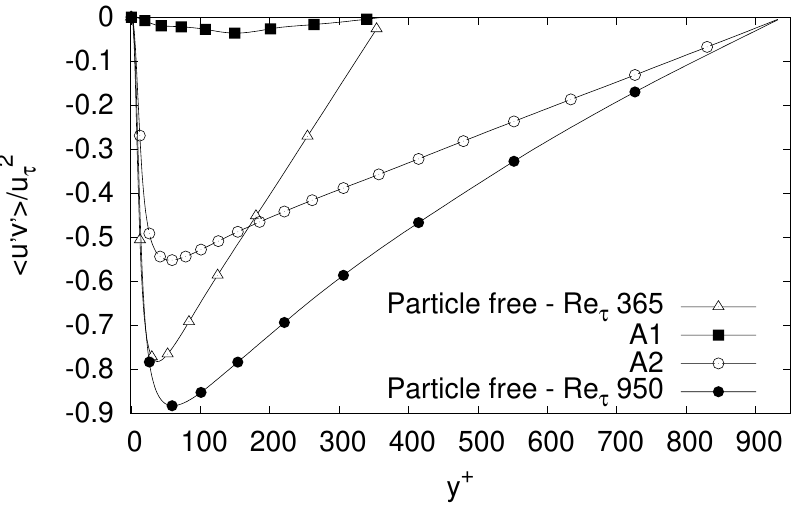
Figure 15. < u (cid:48) v (cid:48) > / u 2 τ - Profiles for A1, A2 and particles free cases. ( A 1 : u τ = 0.073; A2: u τ =